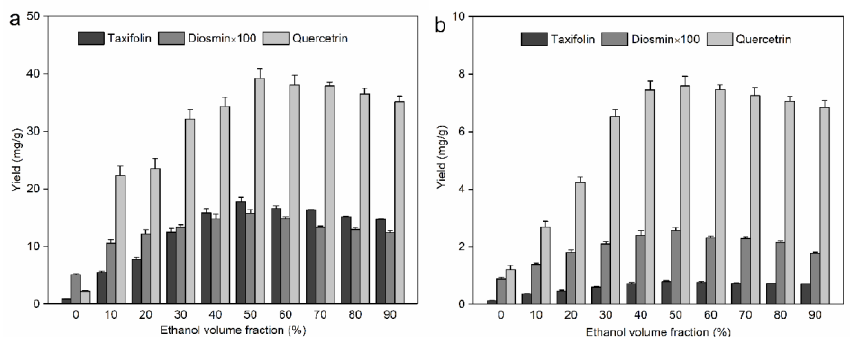
Figure 2. Effect of ethanol volume fraction on the yield of taxifolin, diosmin, and quercetin from Abies nephrolepis leaves ( a ) and bark ( b ).